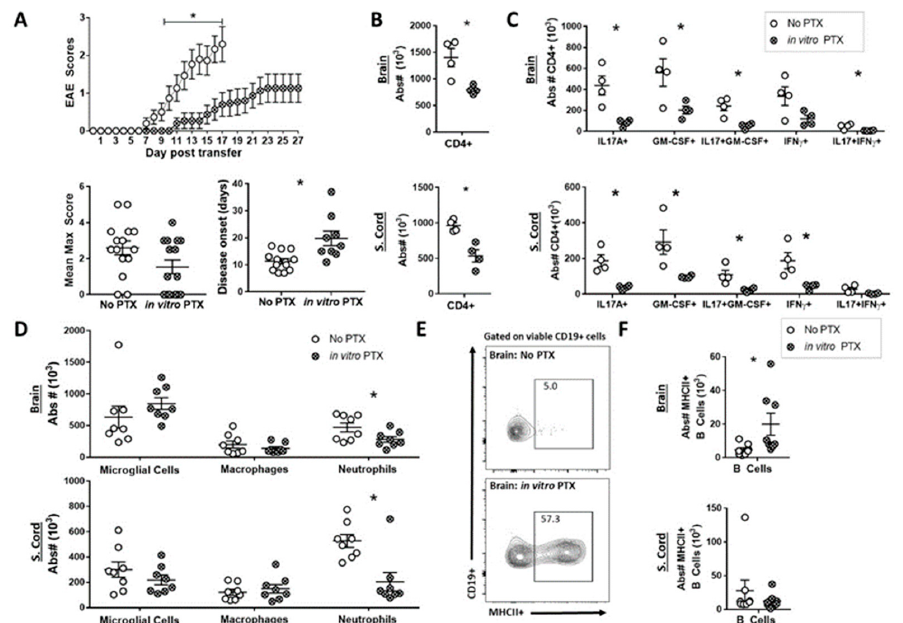
Figure 4. Th17 cells polarized with PTX induced weaker disease during Th17-EAE. MOG-specific Th17 cells